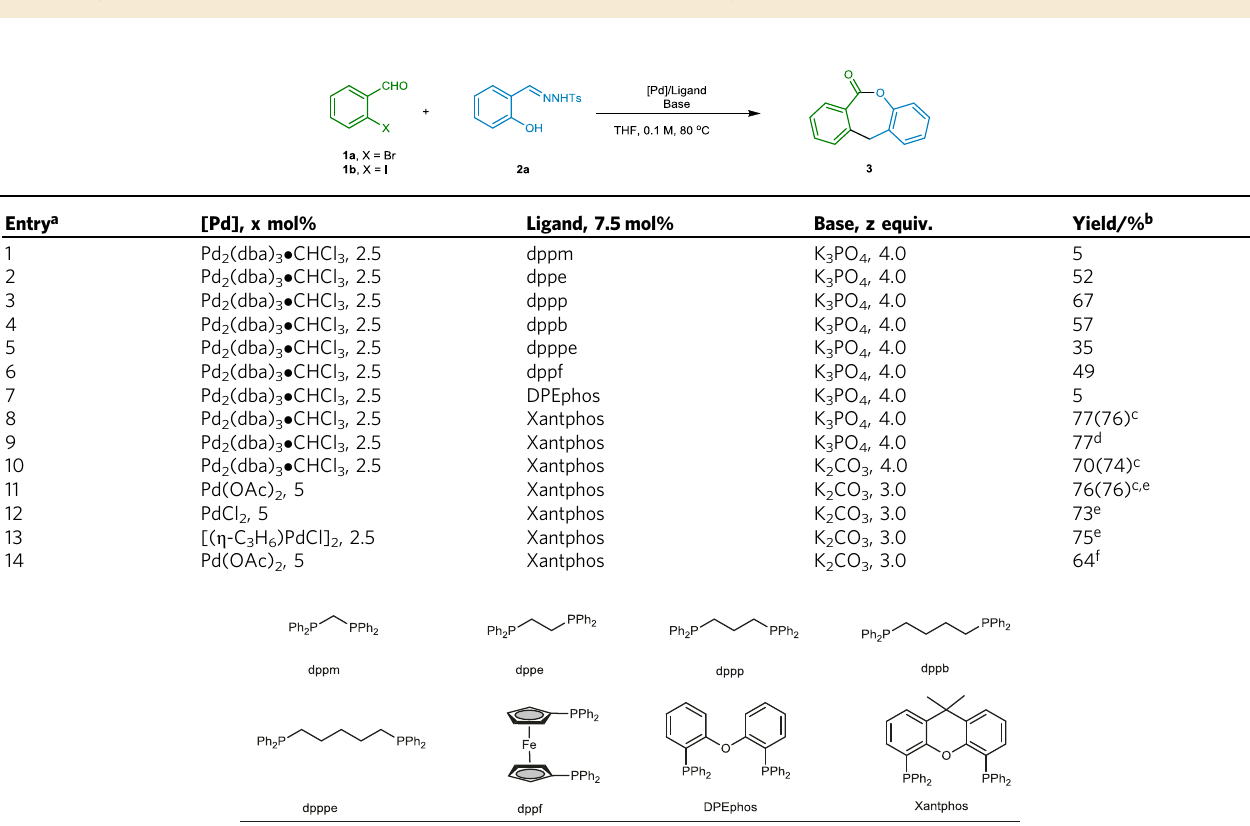
Table 1 Optimization of reaction conditions for seven-membered lactone